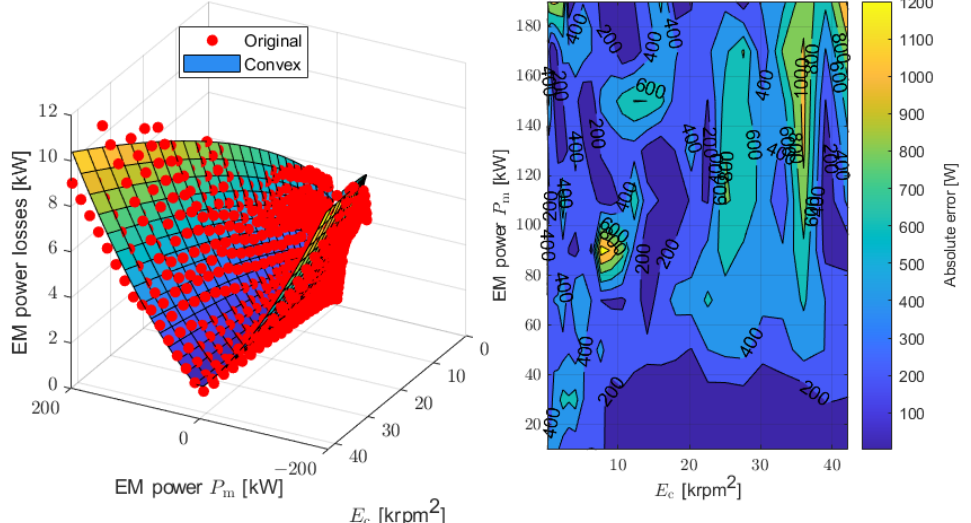
Figure 9. Convex EM power loss model for s τ = 1. The absolute error represents the difference in power loss between the convex model and the original model based on the measurement